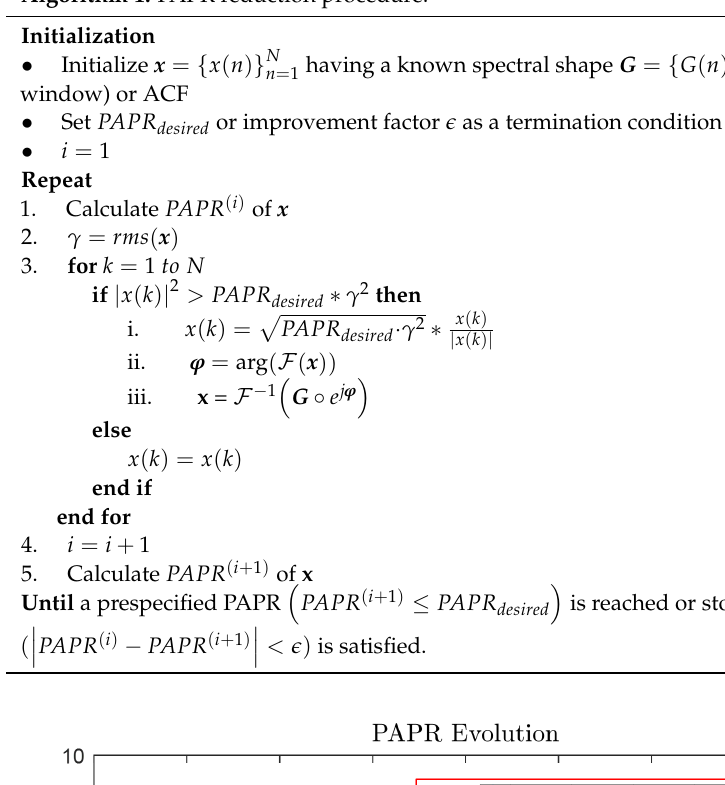
Algorithm 1. PAPR reduction procedure. Initialization